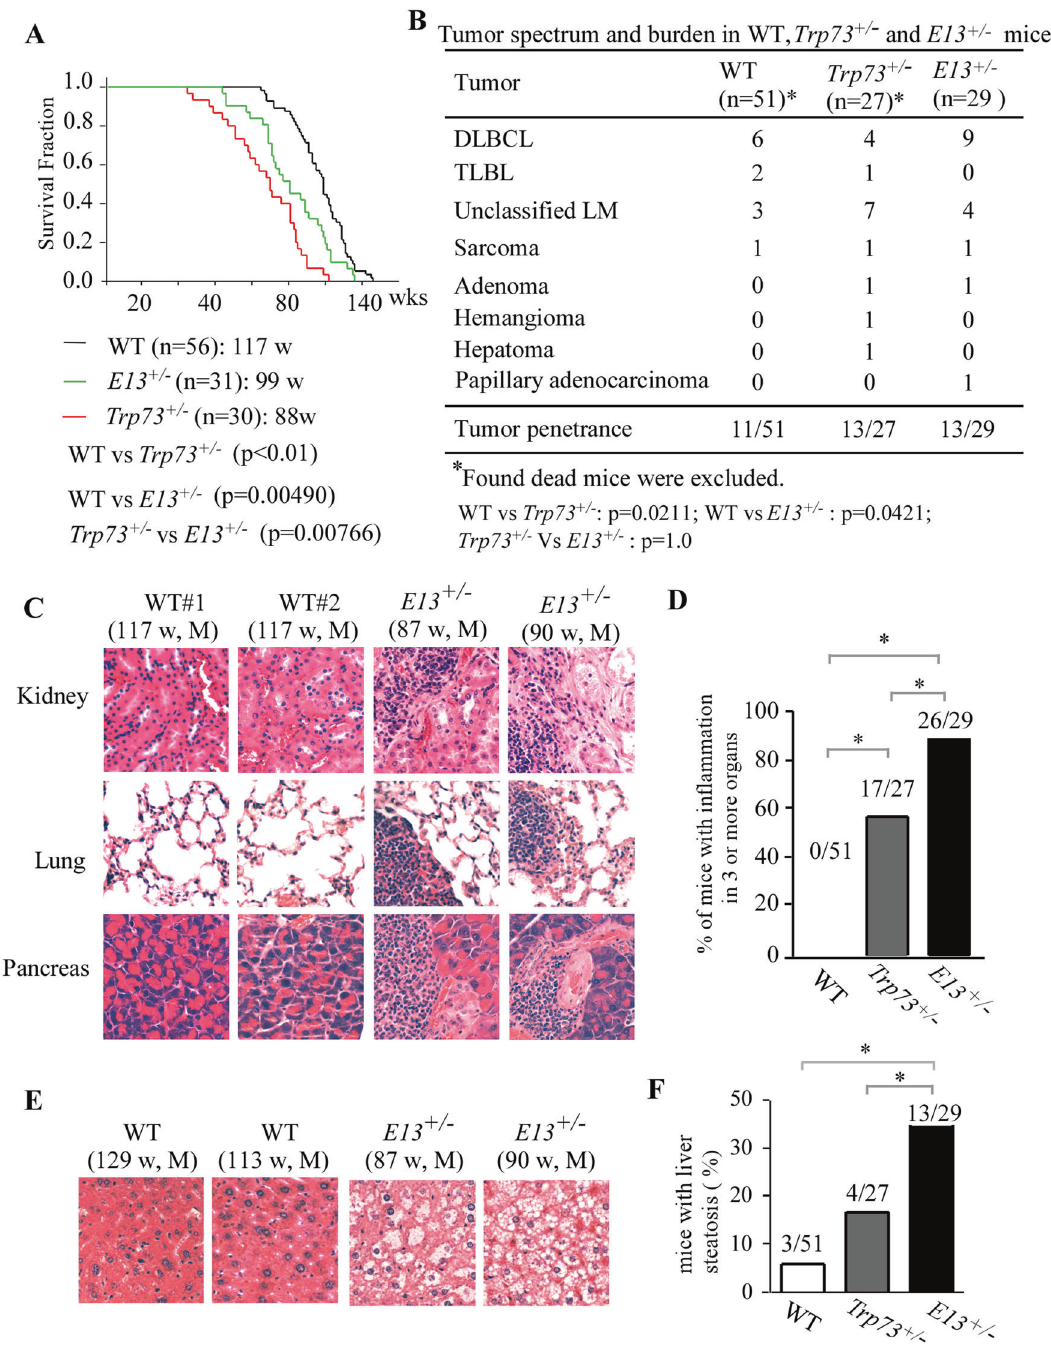
Fig. 3 Mice de fi cient in E13 have a shortened lifespan and are prone to spontaneous tumors, chronic in fl ammation and liver steatosis. A Kaplan-Meyer survival curves of WT ( n = 56), Trp73 + / − (n = 30), and E13 + / − ( n = 31) mice. B Tumor spectra in WT (n = 56), Trp73 + / − ( n = 27), and E13 + / − ( n = 29) mice. C Representative images of H.E. stained kidney, lung and pancreas tissues from WT and E13 + / − mice. D Percentage of WT, Trp73 + / − , and E13 + / − mice with in fl ammation in 3 or more organs. E Representative images of H.E. stained liver tissues from WT and E13 + / − mice. F Percentage of WT, Trp73 + / − , and E13 + / − mice with liver major isoform expressed in E13-KO cells, is responsible for the inhibited cell growth and migration. Loss of E13 promotes cellular senescence in mouse embryonic fi broblasts To gain more insight into the growth suppression mediated by E13-de fi ciency, we generated a mouse model in that Exon 13 in Trp73 gene was deleted by CRISPR-Cas9 (Supplementary Fig. 2A).